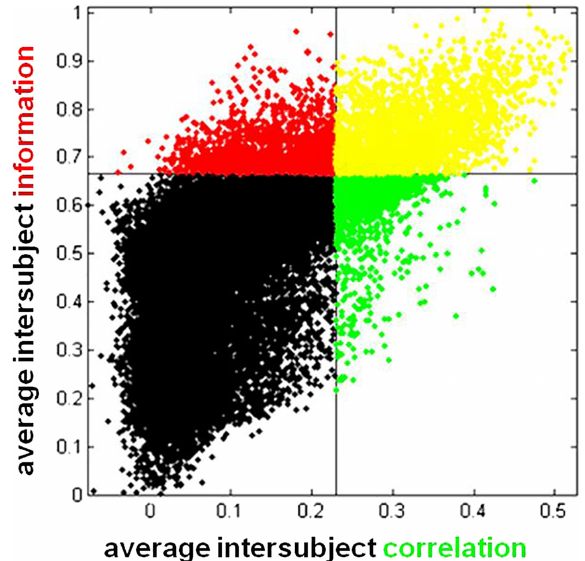
Figure 6 . Relationship between intersubject correlation and intersubject information maps. Each dot in the scatterplot corresponds to a voxel in Talairach space. The horizontal position of each dot is determined by the intersubject correlation (searchlight-average activation correlation computed for each pair of subjects and averaged across all subject pairs). The vertical position of each dot is determined by the intersubject informa- tion ( fi rst canonical correlation between searchlights after searchlight-average activation has been subtracted out for each time point in each subject). The dividing lines correspond to the thresholds controlling the false-discovery rate at 5%. Yellow dots correspond to voxels highlighted in both maps, red dots to voxels highlighted only in the intersubject information map, green dots to voxels highlighted only in the intersubject correlation map. Note that the overall shape of the dot distribution approximates a triangle: low intersubject correlation says little about inter- subject information. However, low intersubject information implies low intersubject